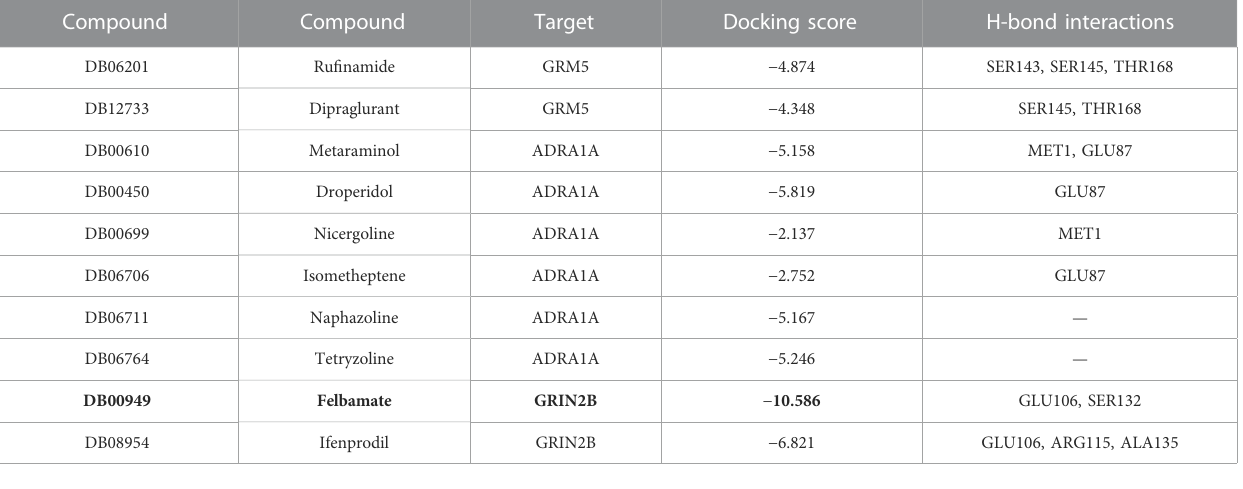
TABLE 2 Molecular docking scores of compounds and proteins and the important interactions generated. Compound